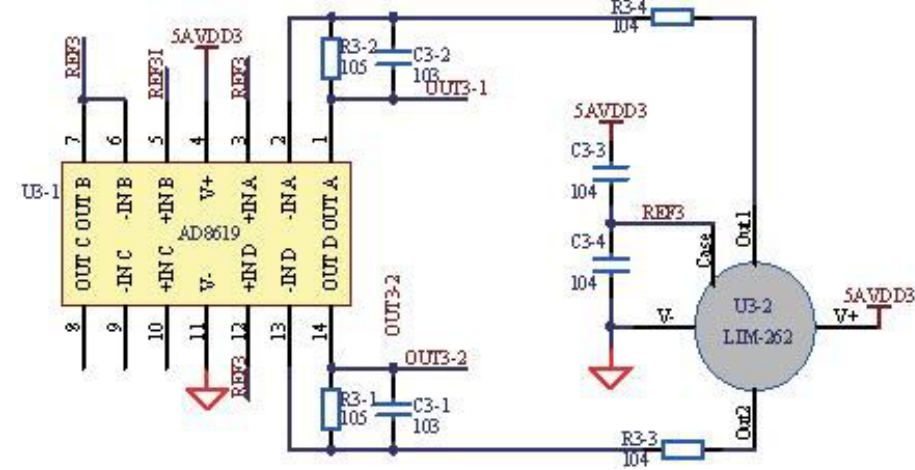
Figure 7. Application circuit of the pyroelectric